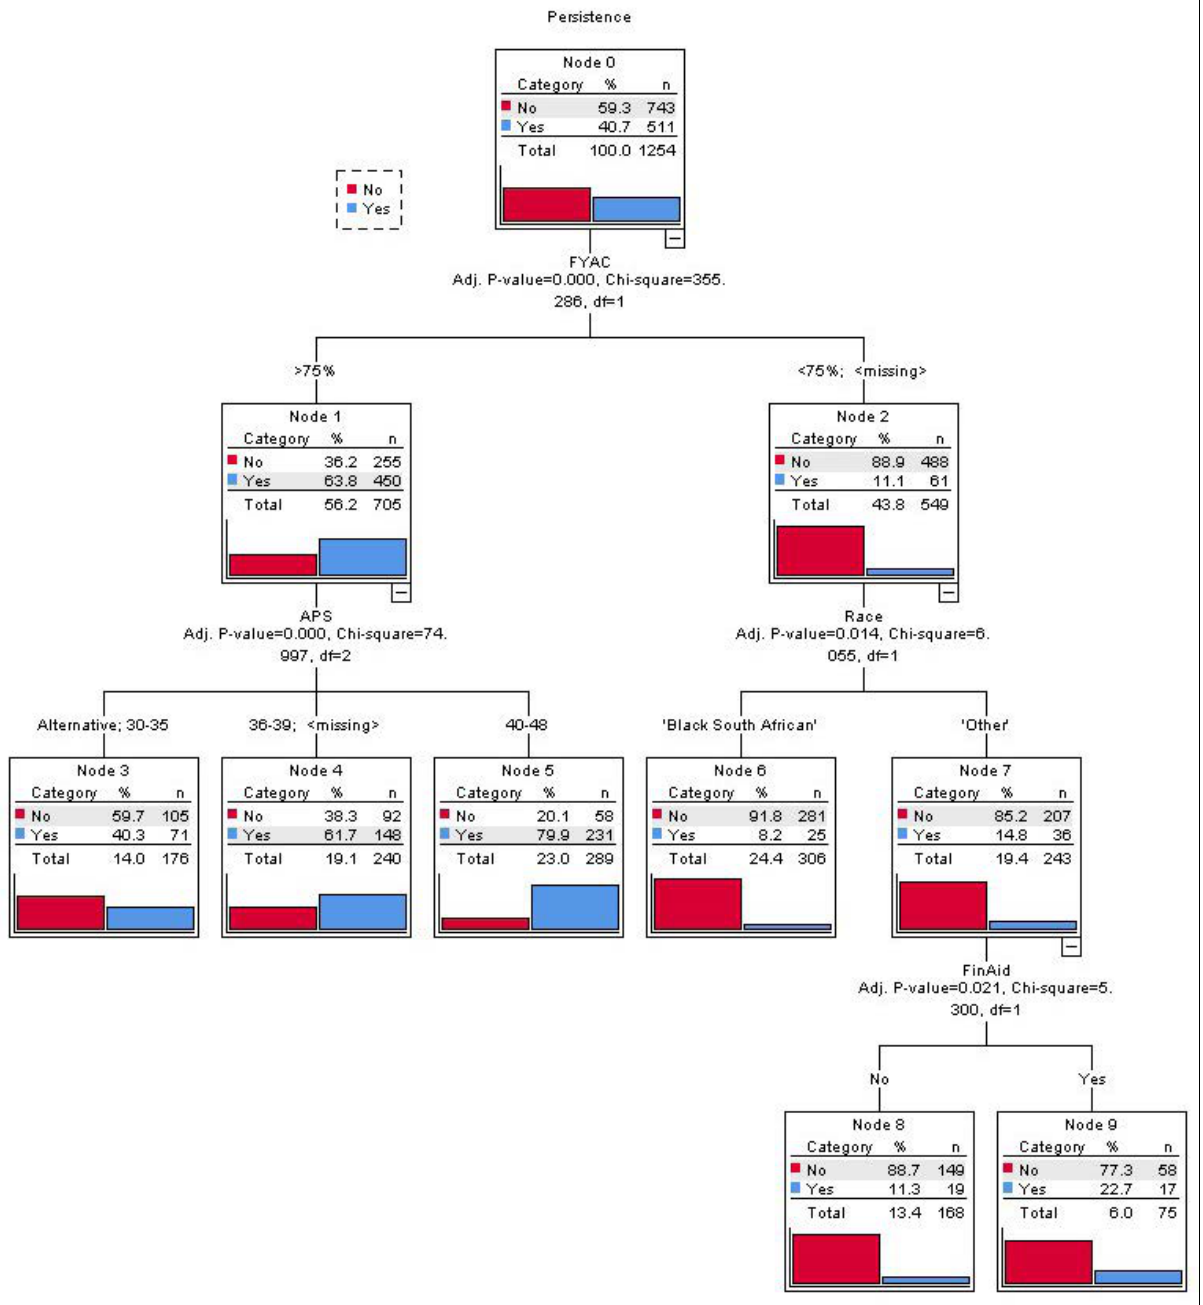
Figure 4: Classification tree model of persistence in engineering, n